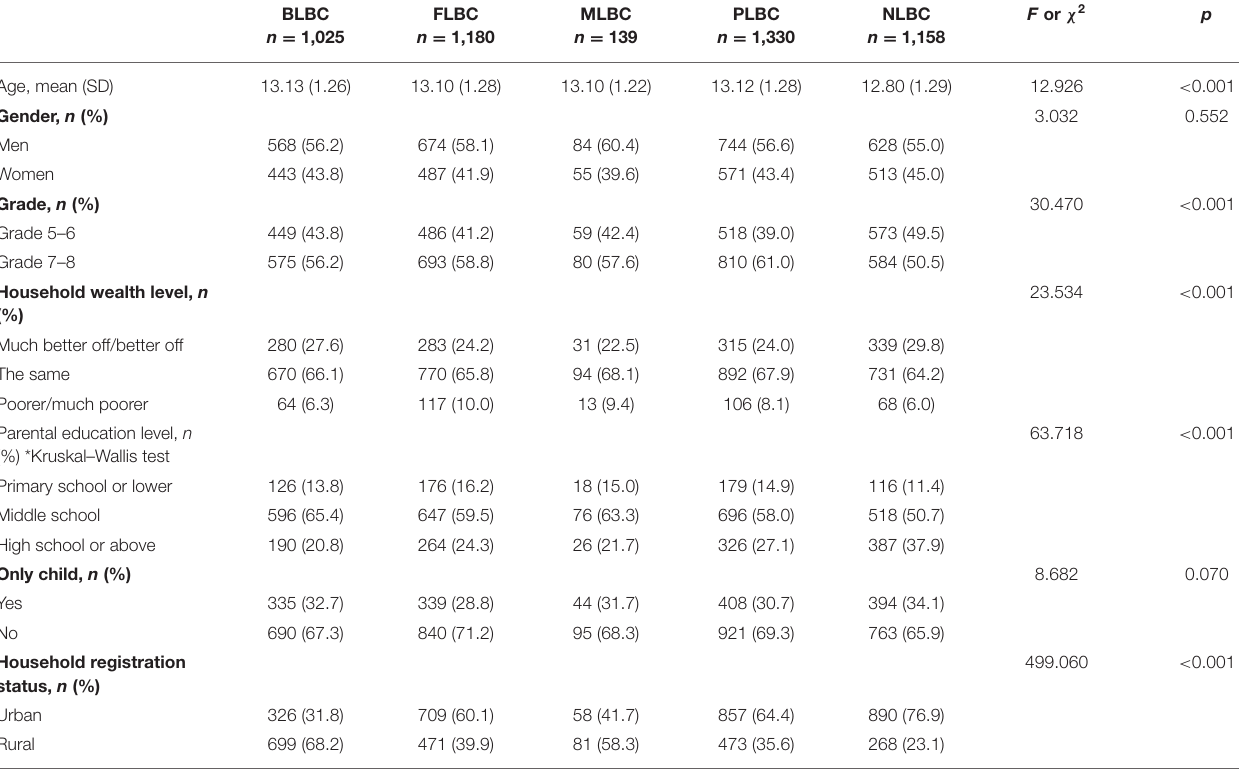
TABLE 1 | Sample characteristics of study participants by parental migration status, mean (SD)/ n (%).